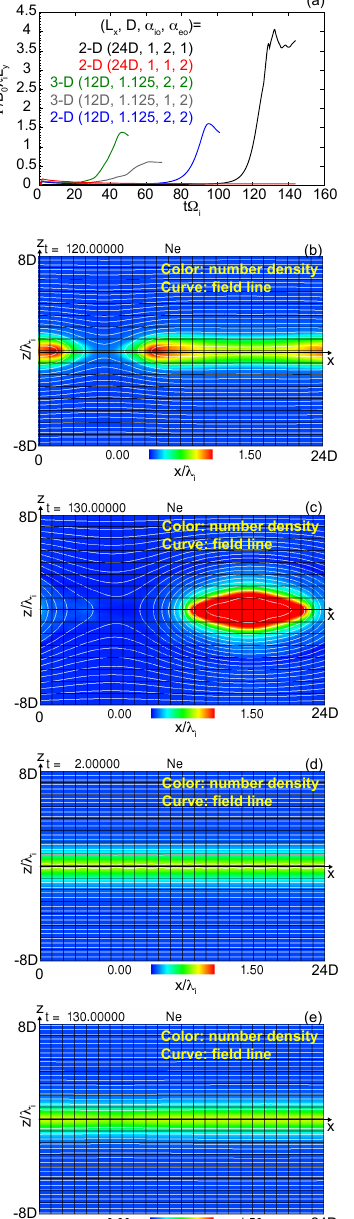
Fig. 5. Effects of the ion temperature anisotropy on the saturation level. (a) The temporal developments of reconnected flux 9 from various runs. (b) and (c) 2-D XZ contours of plasma number density (color) and the field lines (black curve) at t =120 and 130, respec- tively, from the 2-D ( L x , D , α io , α eo ) =(24 D , 1, 2, 1) case. (d) and (e) 2-D XZ contours of plasma number density (color) and the field lines (black curve) at t =2 and 130, respectively, from the 2-D ( L x , D , α io , α eo ) =(24 D , 1, 2, 1) case. The runs showing high saturation level of 9 , as high as to attain reconnection fully across the current sheet, are all with α io